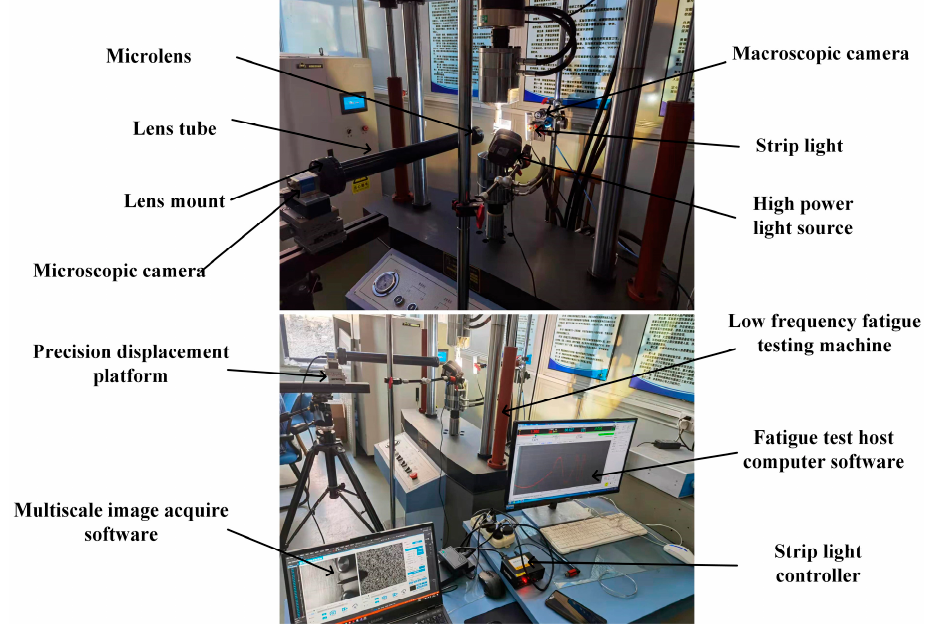
Figure 6. Experimental platform.